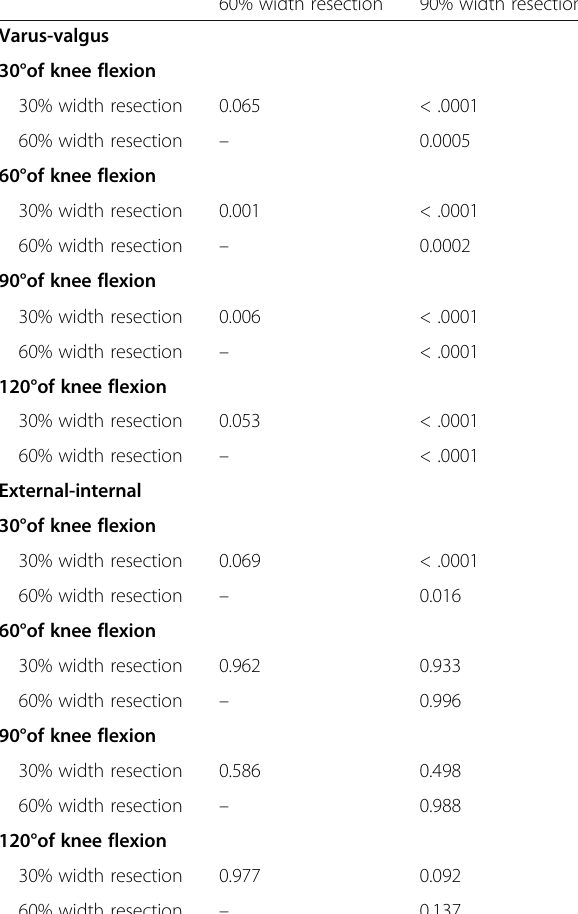
Table 3 All p-values of the statistical comparisons for tibiofemoral alignment between each meniscal